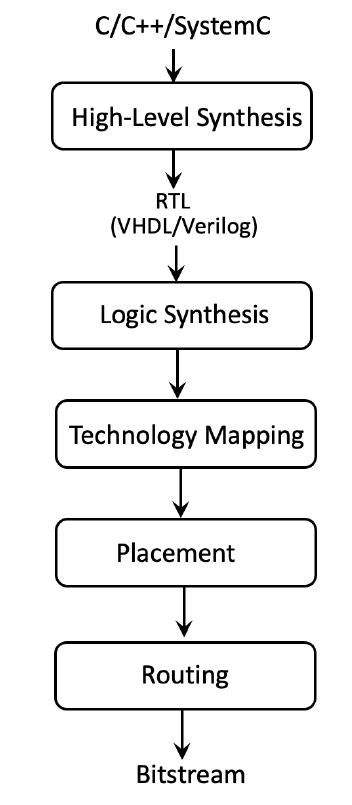
Figure 1. FPGA Design